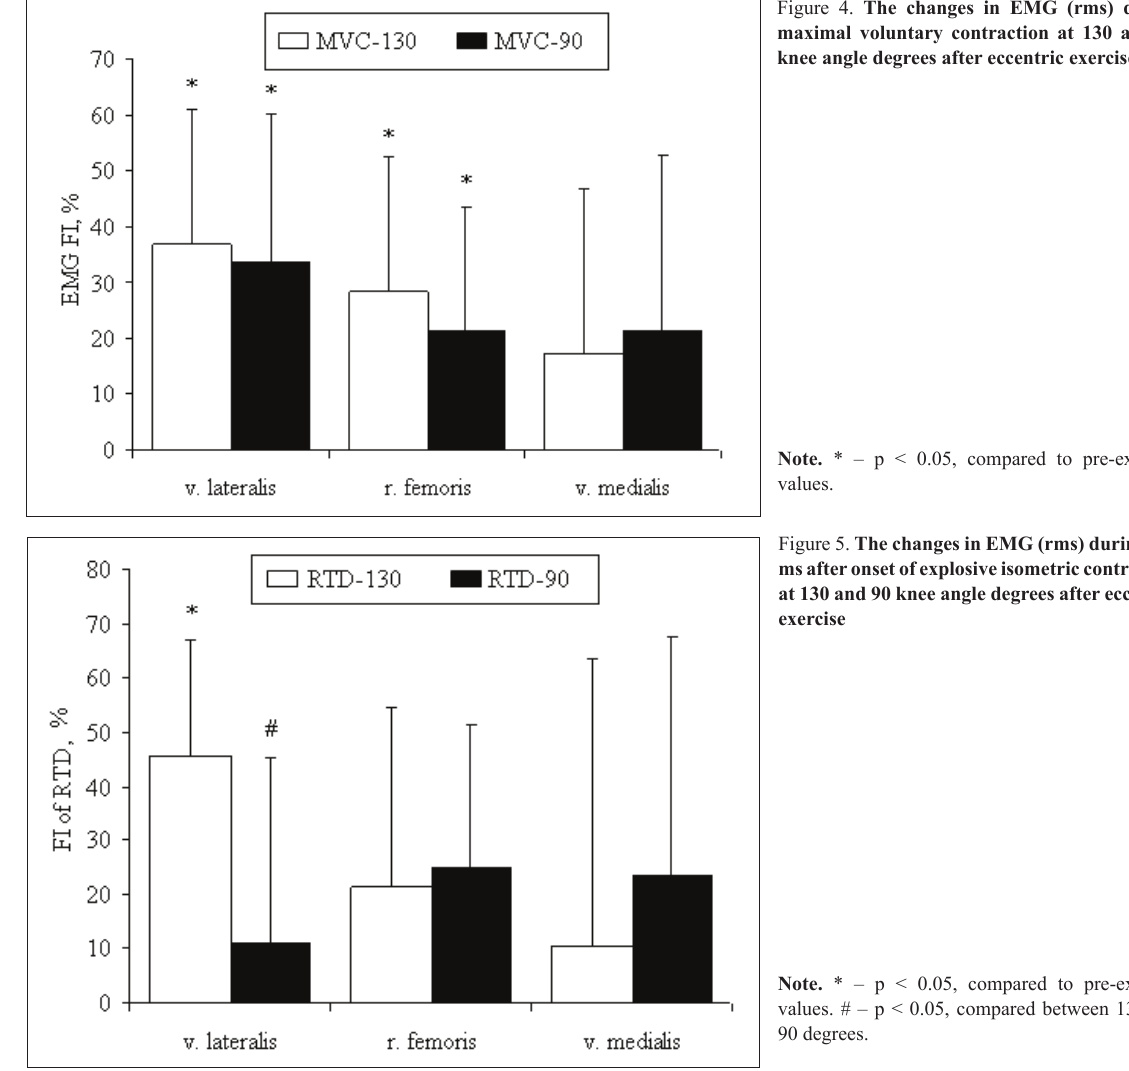
Figure 4. The changes in EMG (rms) during maximal voluntary contraction at 130 and 90 knee angle degrees after eccentric exercise